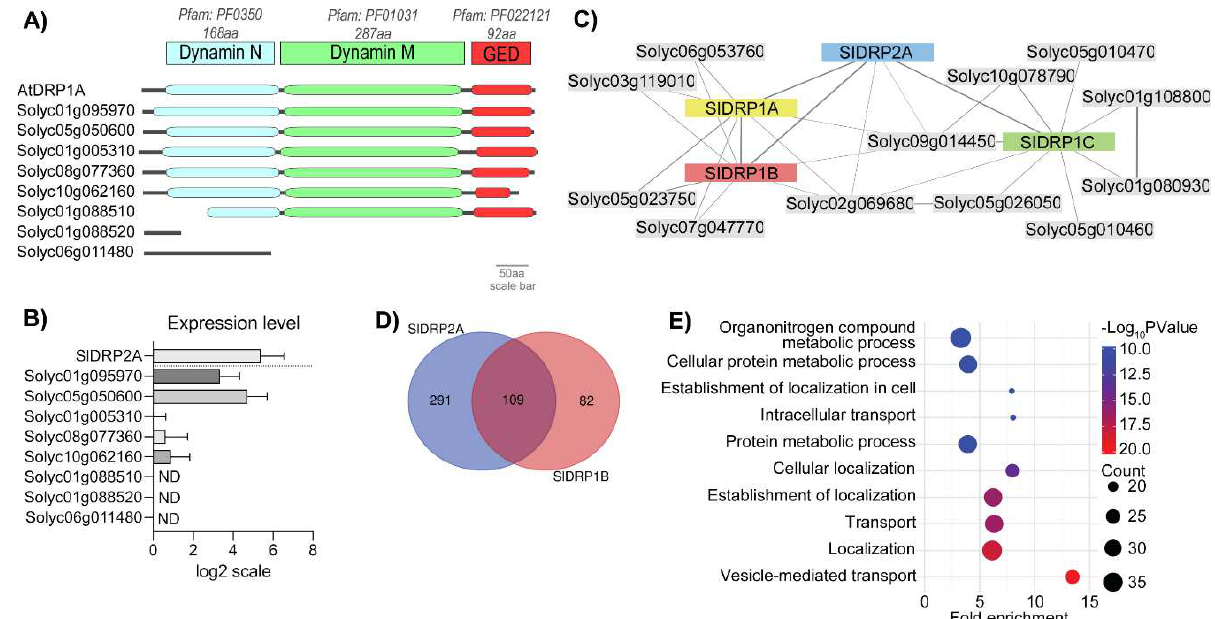
Figure 1. Bioinformatic analysis of tomato DRP1 orthologues. ( A ) Protein domain analysis was per this figure. Orthologues: Solyc01g095970, Solyc05g050600, Solyc01g005310, Solyc08g077360, Solyc10g062160, Solyc01g088510, Solyc01g088520, and Solyc06g011480. ( B ) Gene expression analysis of tomato DRP1 orthologues was performed using GENEVETIGATOR®. ( C ). Interactome network of SlDRP1A, SlDRP1B, and SlDRP1C based on PTIR database (Supplementary Table S2). ( D ) Venn diagram of SlDRP1B and SlDRP2A co-expressed genes based on GENEVETIGATOR® database. ( E) GO overrepresentation analysis of SlDRP1B co-expressed genes.